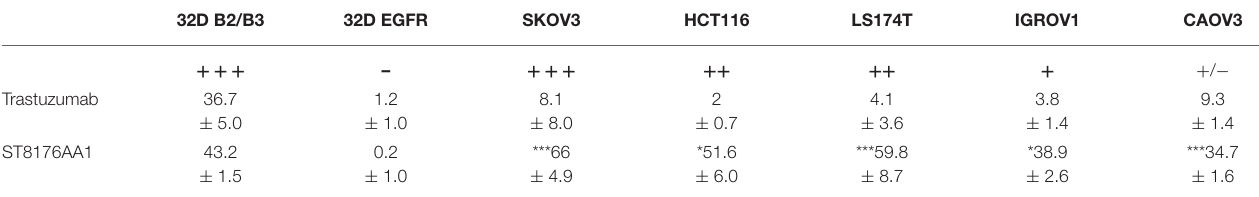
TABLE 1 | ST8176AA1 inhibits more than trastuzumab ErbB2-dependent cell